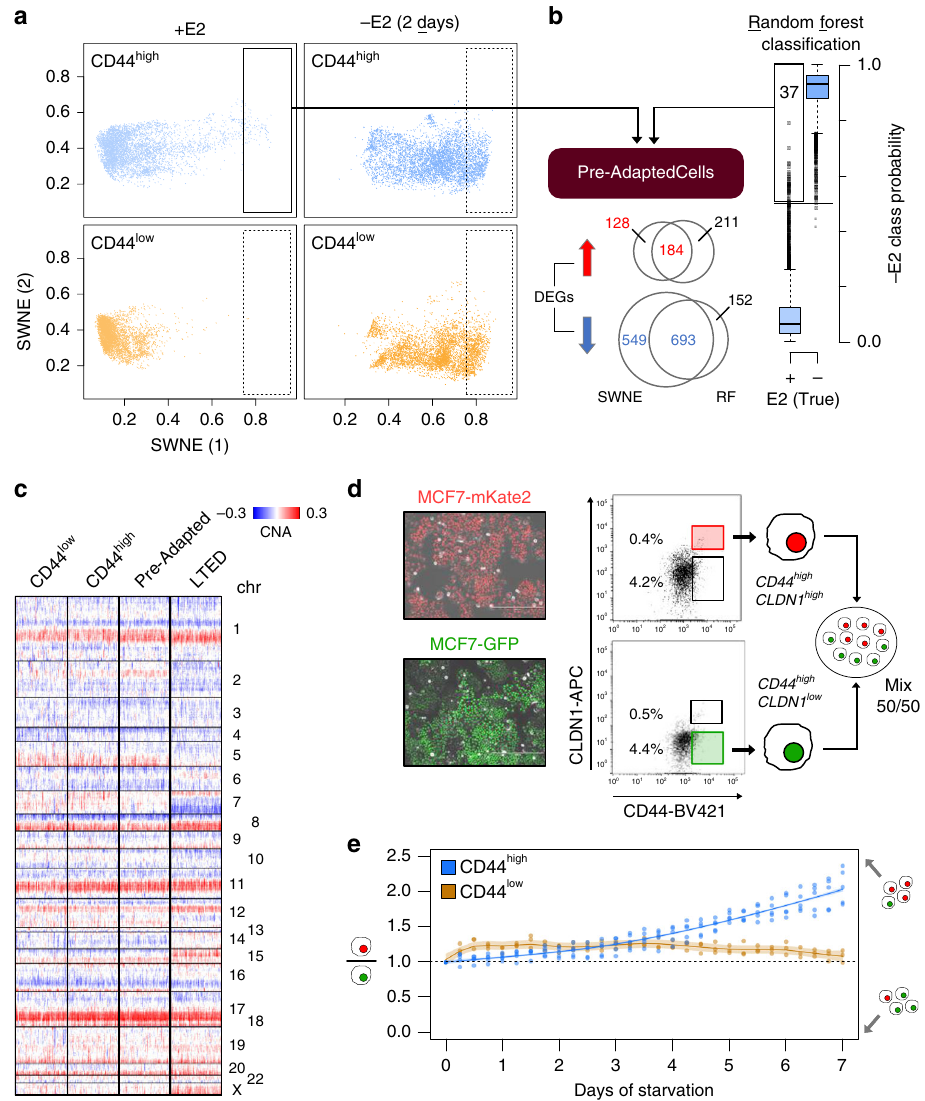
Fig. 4 Single-cell transcriptomics identi fi es pre-adapted cells. a Dimensionality reduction of single-cell transcriptional pro fi les of oestrogen-supplemented ( + E2; top) or deprived ( − E2; 2 days) cells. Pre-adapted (PA) cells highlighted in boxes. b PA cells identi fi cation using two different strategies (SWNE and Random Forests). DEGs: differentially expressed genes. Box plots show median, interquartile values, range and outliers (individual points). c Copy number pro fi les of PA cells ( n = 81), along with the same number of LTED, CD44 low and CD44 high (not PA) cells, as estimated from scRNA-seq pro fi les. d Sorted PA cells (CD44 high and CLDN1 high ) stably labelled with mKate2 were mixed with other plastic cells (CD44 high and CLDN1 low ) stably labelled with GFP (scale bar = 400 μ m) and followed up for 7 days upon E2 deprivation ( e